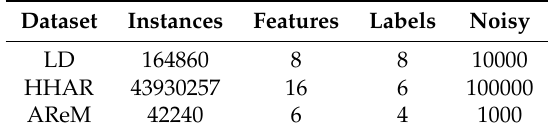
Table 1. Description of various datasets.